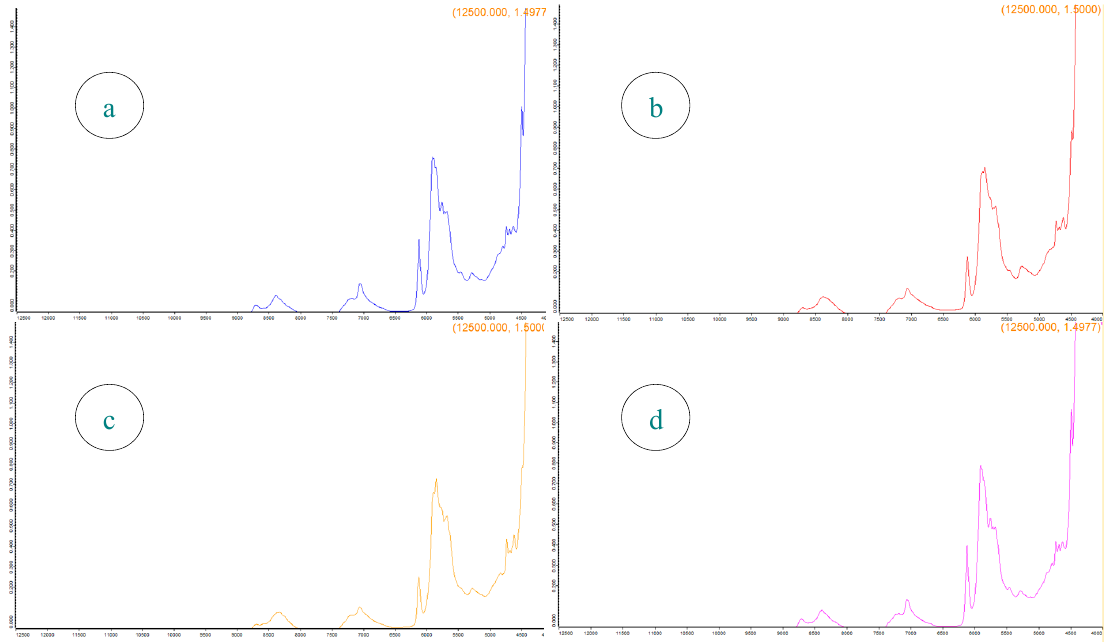
Figure 3. Near infrared spectra of the essential oils from four different harvesting time. The insertion is the inset evidence of the peaks between 4000–12,500 cm − 1 : ( a ) MK15, ( b ) MK36, ( c ) MK45 and ( d ) MK60.